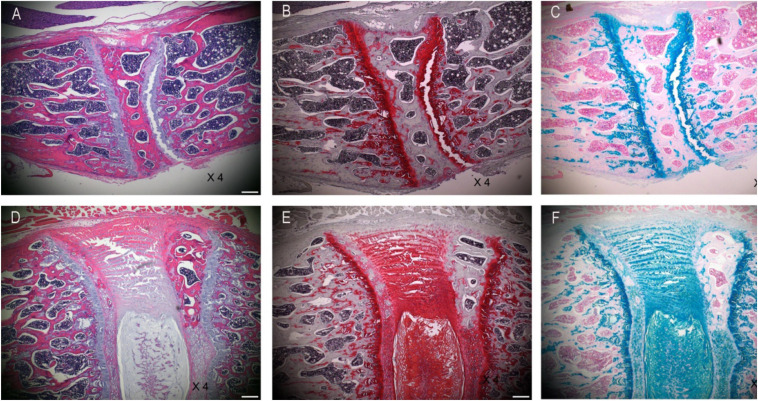
Histological changes validate of DLBP model. Panels (A,D) are H&E staining of intervertebral disk. Panels (B,E) are Safranin O staining of intervertebral disk. Panels (C,F) are Alcin Blue staining of intervertebral disk.